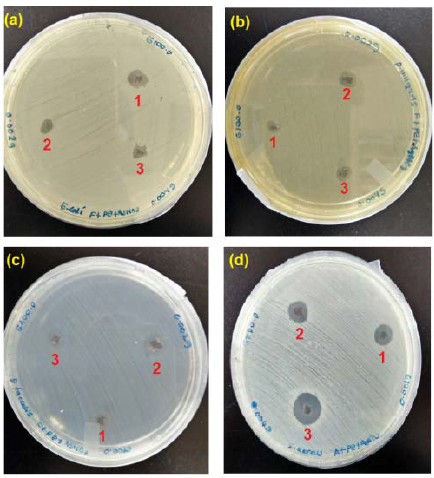
Figure 15. The images of inhibition zones growth against ( a ) E. coli , ( b ) P. vulgaris , ( c ) E. faecalis and ( d ) S. aureus around the different mass of C. pentandra incorporated with Ag-NPs at 1 (1 mg), 2 (2 mg), and 3 (4 mg). Table 1. The diameter of the growth inhibition zone of C. pentandra /Ag-NPs against different bacteria species. The Diameter of Growth Inhibition Zone (mm) a Bacteria species